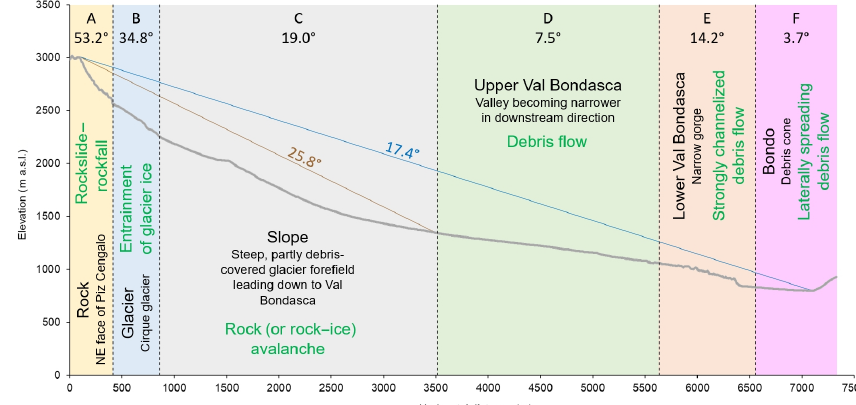
Figure 4. Profile along the main flow path of the Piz Cengalo–Bondo landslide cascade. The letters A–F indicate the individual zones (Table 1 and Fig. 7), whereas the associated numbers indicate the average angles of reach along the profile for each zone. The brown number and line show the angle of reach of the initial landslide (rockslide–rockfall and rock – or rock—ice – avalanche), whereas the blue number and line show the angle of reach of the entire landslide cascade. The geomorphic characteristics of the zone (in black) are indicated along with the dominant process type (in green).